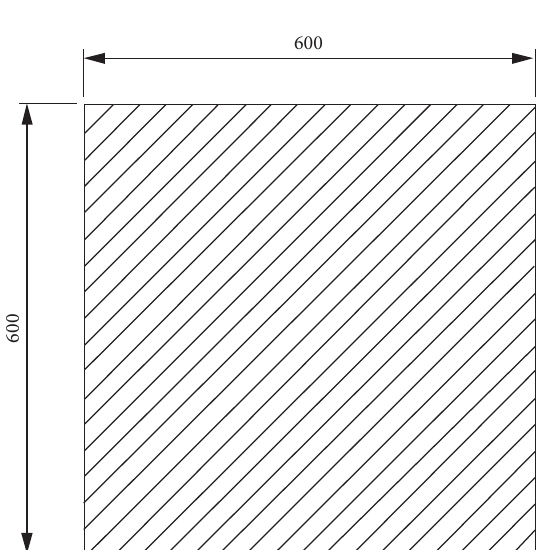
Figure 3: Cross section of pile (mm).